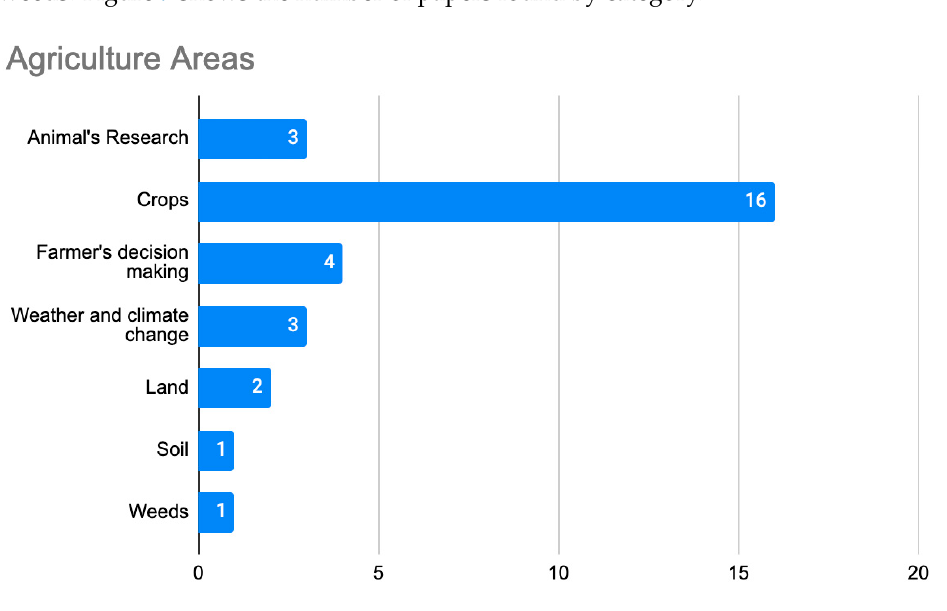
Figure 9. Number of solutions in agricultural Big Data and ML by industry.